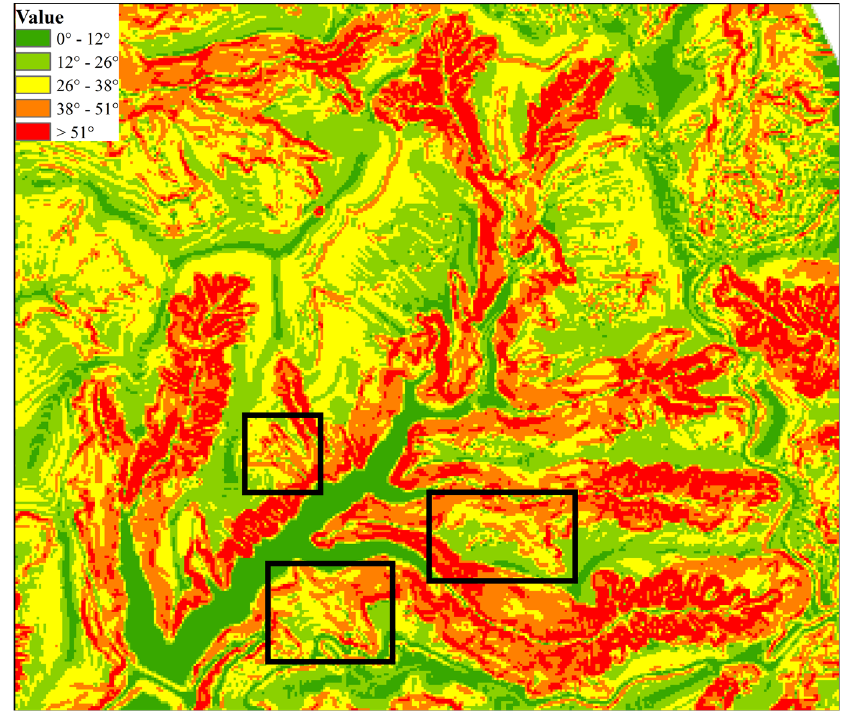
Figure 15. Slope of the experimental areas.